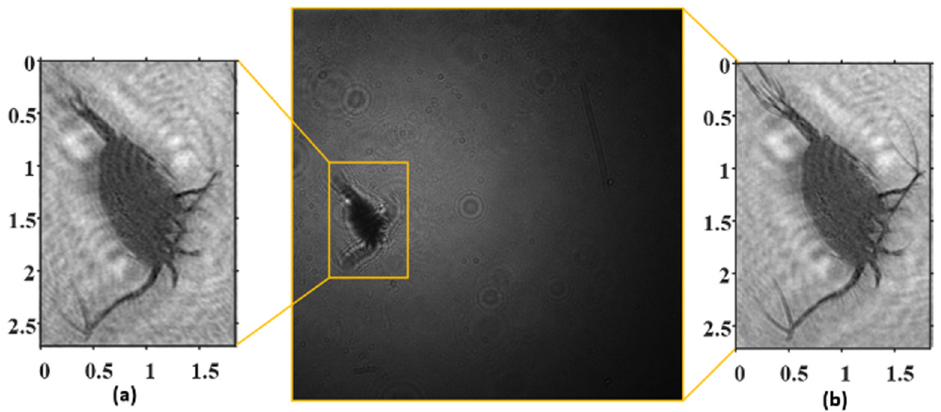
Figure 7. The reconstructed partial hologram ( a ) and whole hologram ( b ) in steps of 5 mm, respec- tively. The reconstructed image at the focus location is selected from 33 sections. Obtaining ( a ) took 1.558 s, whereas ( b ) took 32.875 s (scale in mm).